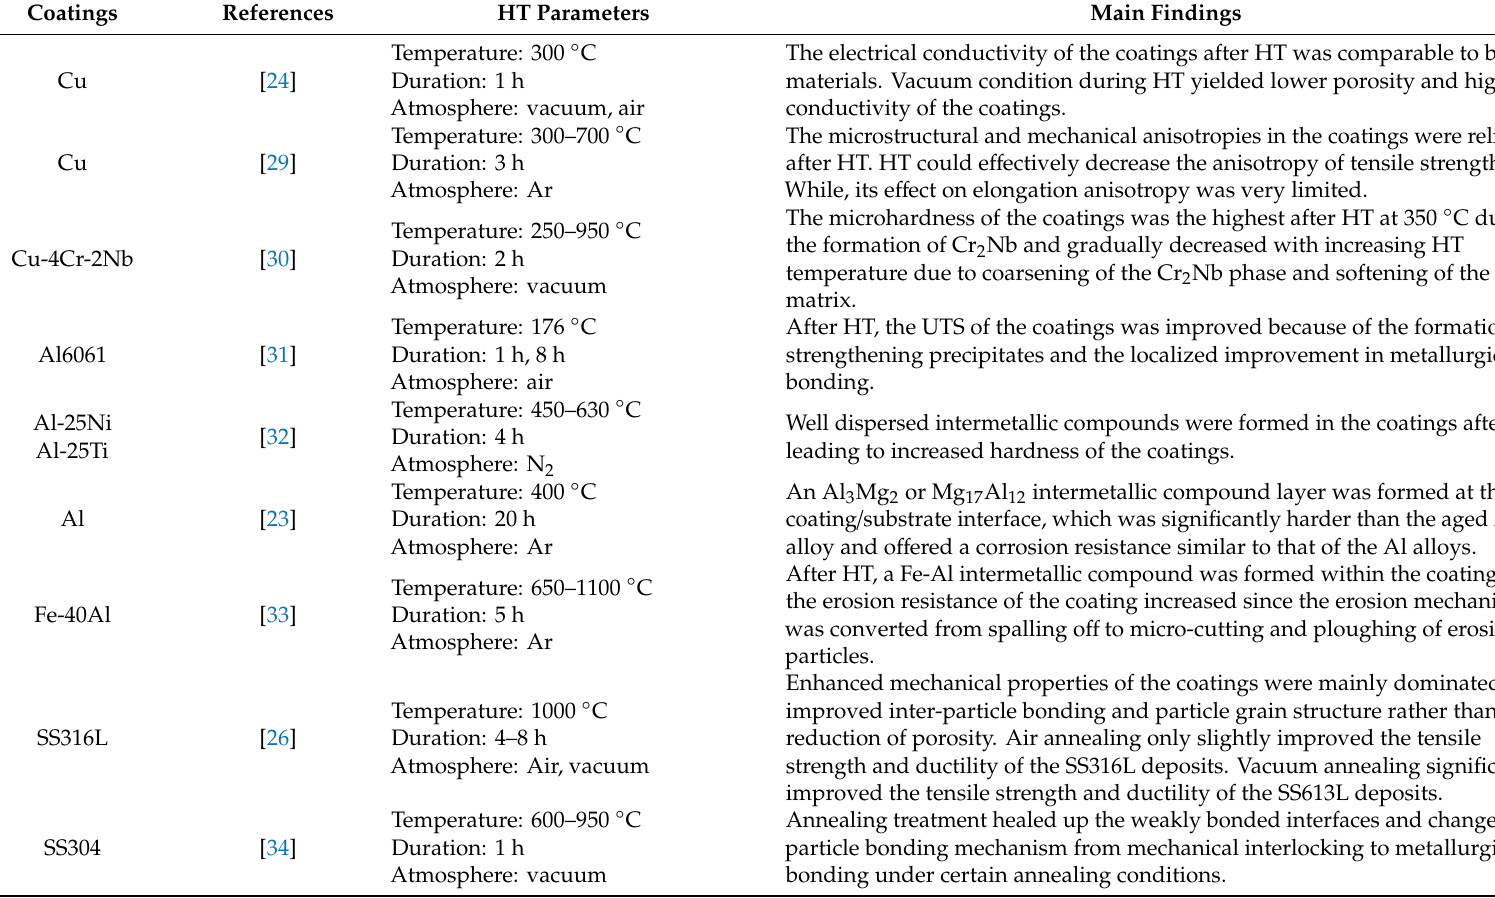
Table 1. E ff ect of heat treatment on cold sprayed